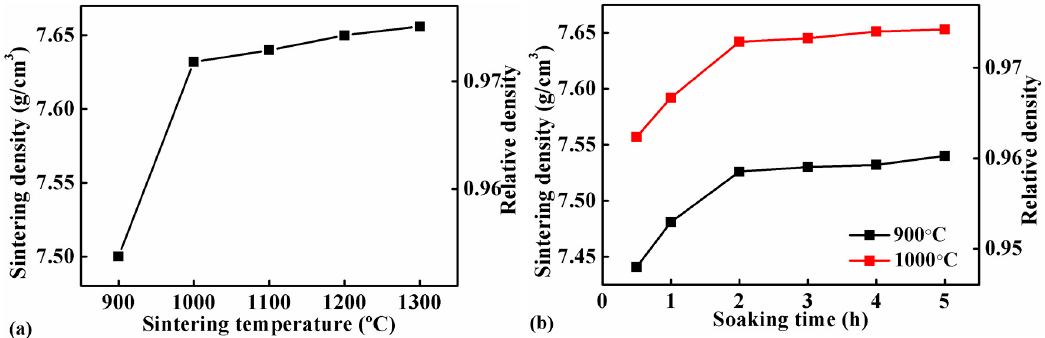
Figure 2. Sintering densities of Fe-0.8%P samples sintered at different temperatures for 2 h ( a ), and those sintered at 900 °C and 1000 °C for different periods of time ( b ). Table 1. A summary of green densities of Fe-x P (x = 0, 0.6, 0.8, 1.0, 1.2, 1.4, and 1.6 wt.%) samples sintered at 1000 ◦ C for different times.